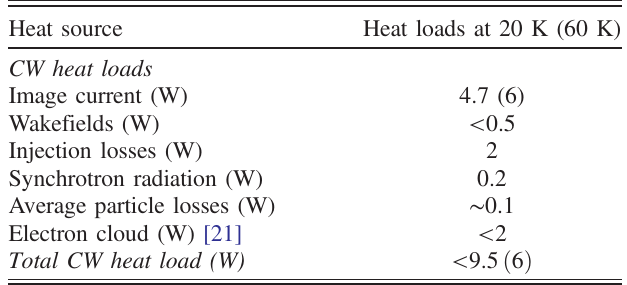
TABLE III. Predicted beam-related heat loads on 2-m-long SCU0 vacuum chamber, assuming 100 mA beam